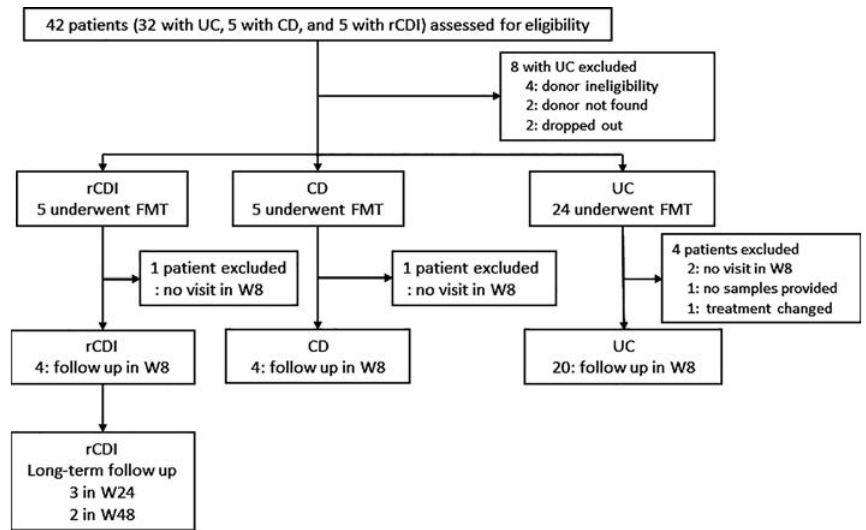
Figure 1 Study design. FMT: fecal microbiota transplantation, rCDI: recurrent Clostridioides difficile infection, CD: Crohn’s disease, UC: ulcerative